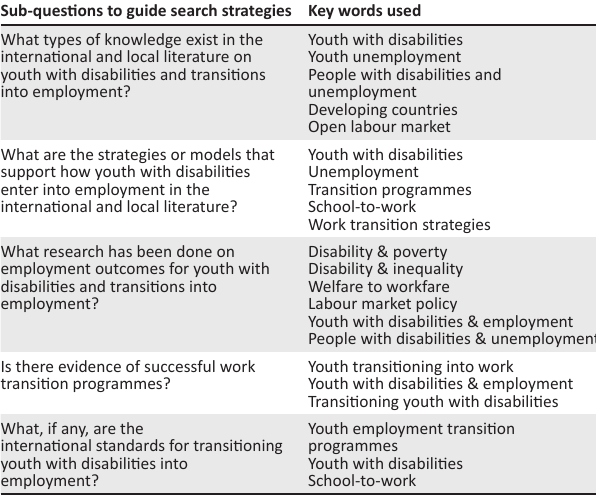
TABLE 1: Search strategies and key words. Sub-questions to guide search strategies Key words